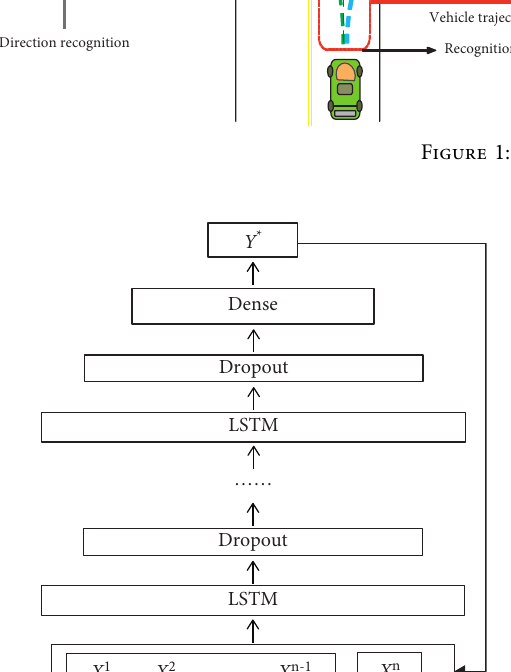
Figure 1: Overview of our method.